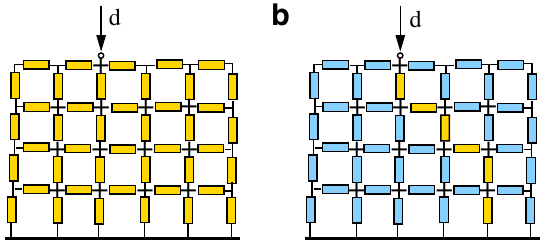
Figure 2. Electrical current distribution at steady state. The current is scattered in the case of linear resistances ( a ) and concentrated along a single path in the case of threshold characteristics ( b ), when the current flows along the path that minimizes the sum of the dielectric rigidities of its links. Yellow (resp. blue) means presence (resp. absence) of flowing current.